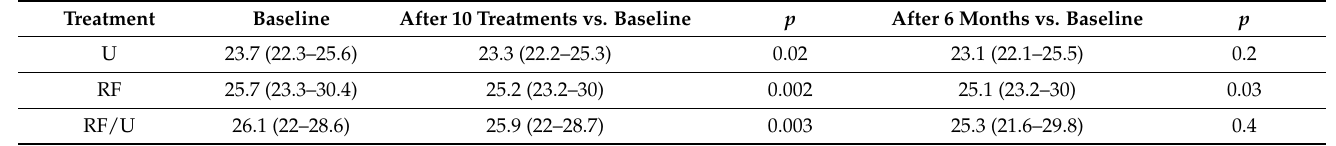
Table 4. BMI in the studied women [kg/m 2 ].